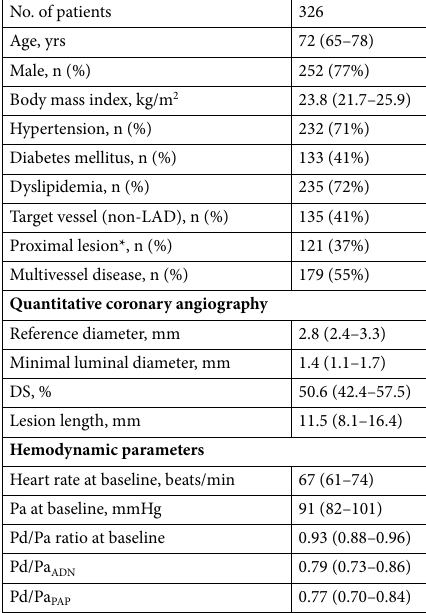
Table 1. Patient and lesion characteristics. Values are expressed as medians (interquartile ranges) or frequencies (percentages). *Proximal location was defined as Syntax segments 1, 5, 6, and 11. DS diameter stenosis, LAD left anterior descending coronary artery, Pa aortic pressure, Pd/Pa distal-to-aortic pressure ratio, Pd/Pa ADN distal-to-aortic pressure ratio associated with adenosine, Pd/Pa ADN distal-to-aortic pressure ratio associated with